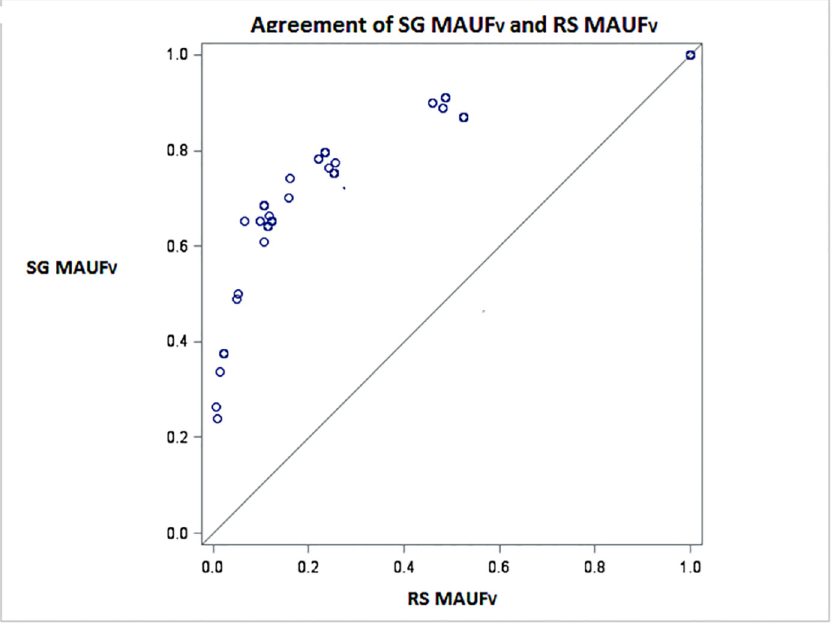
Fig 6. Scatter plot to assess agreement between the SG MAUF V and the RS MAUF V for the validation